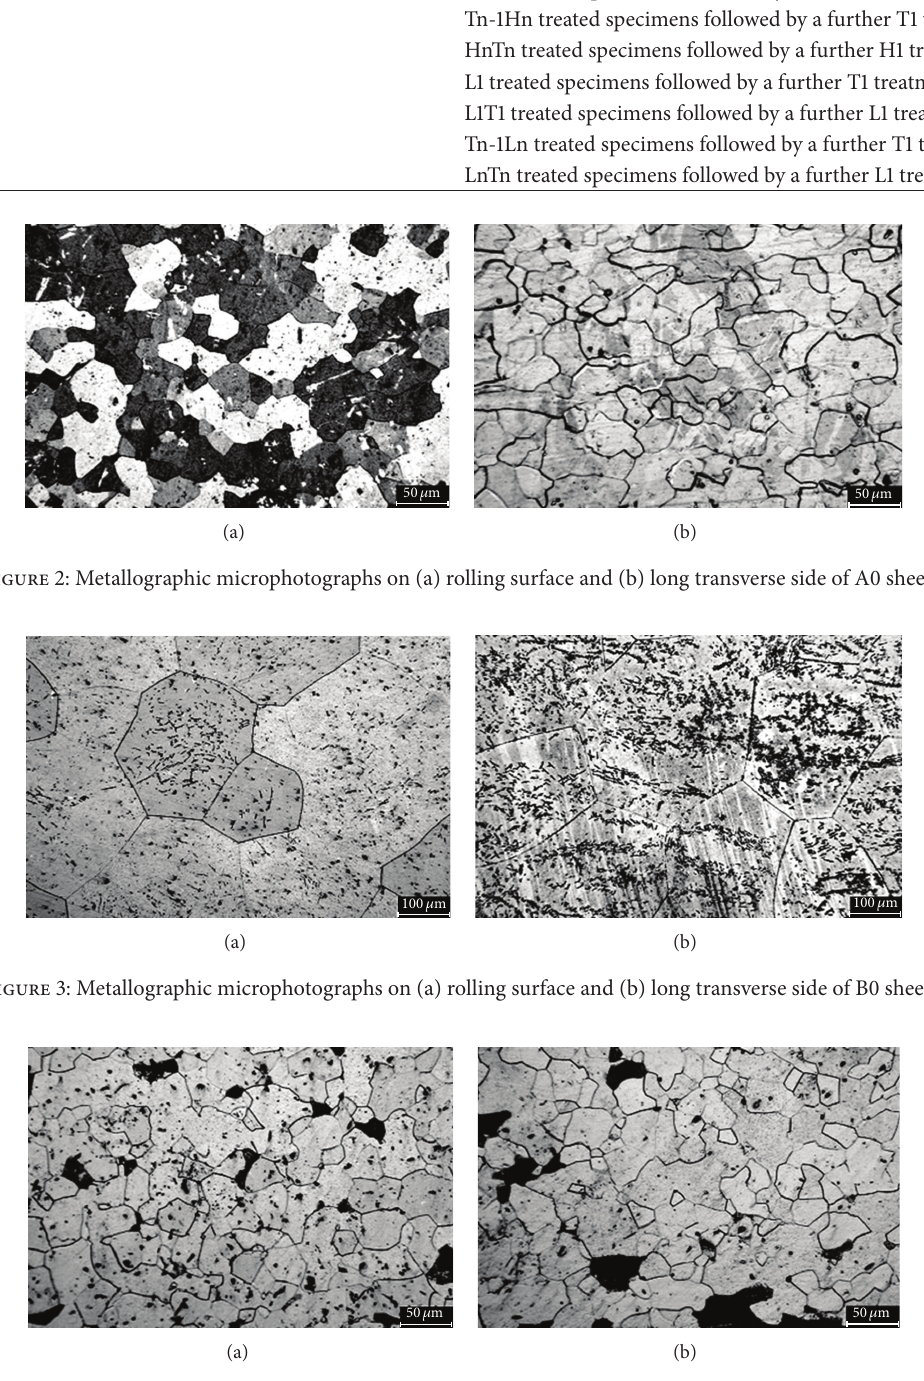
Figure 4: Metallographic microphotographs on (a) rolling surface and (b) long transverse side of C0